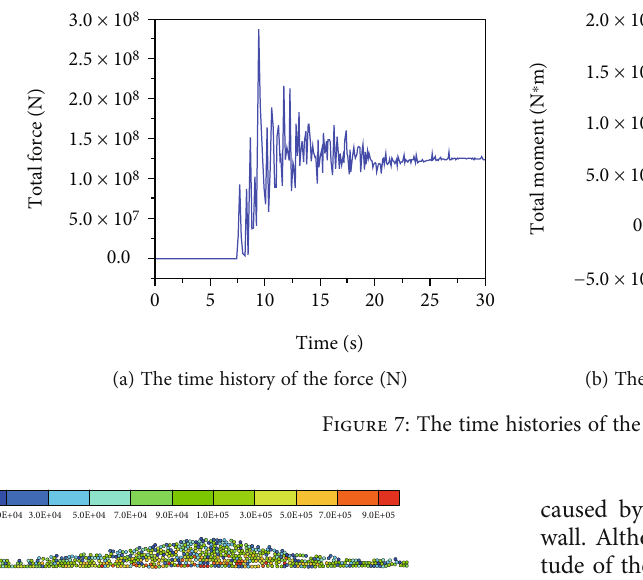
Figure 8: Contact force distribution on rigid retaining wall in stable state